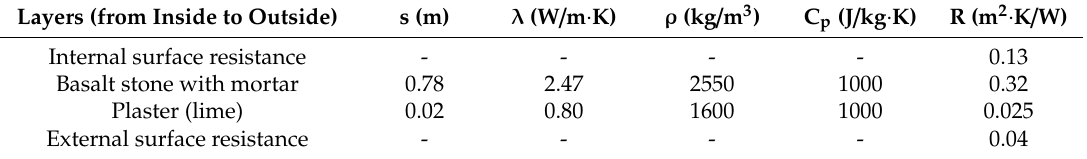
Table 1. Thermophysical properties of the external walls for the building in its current configuration.